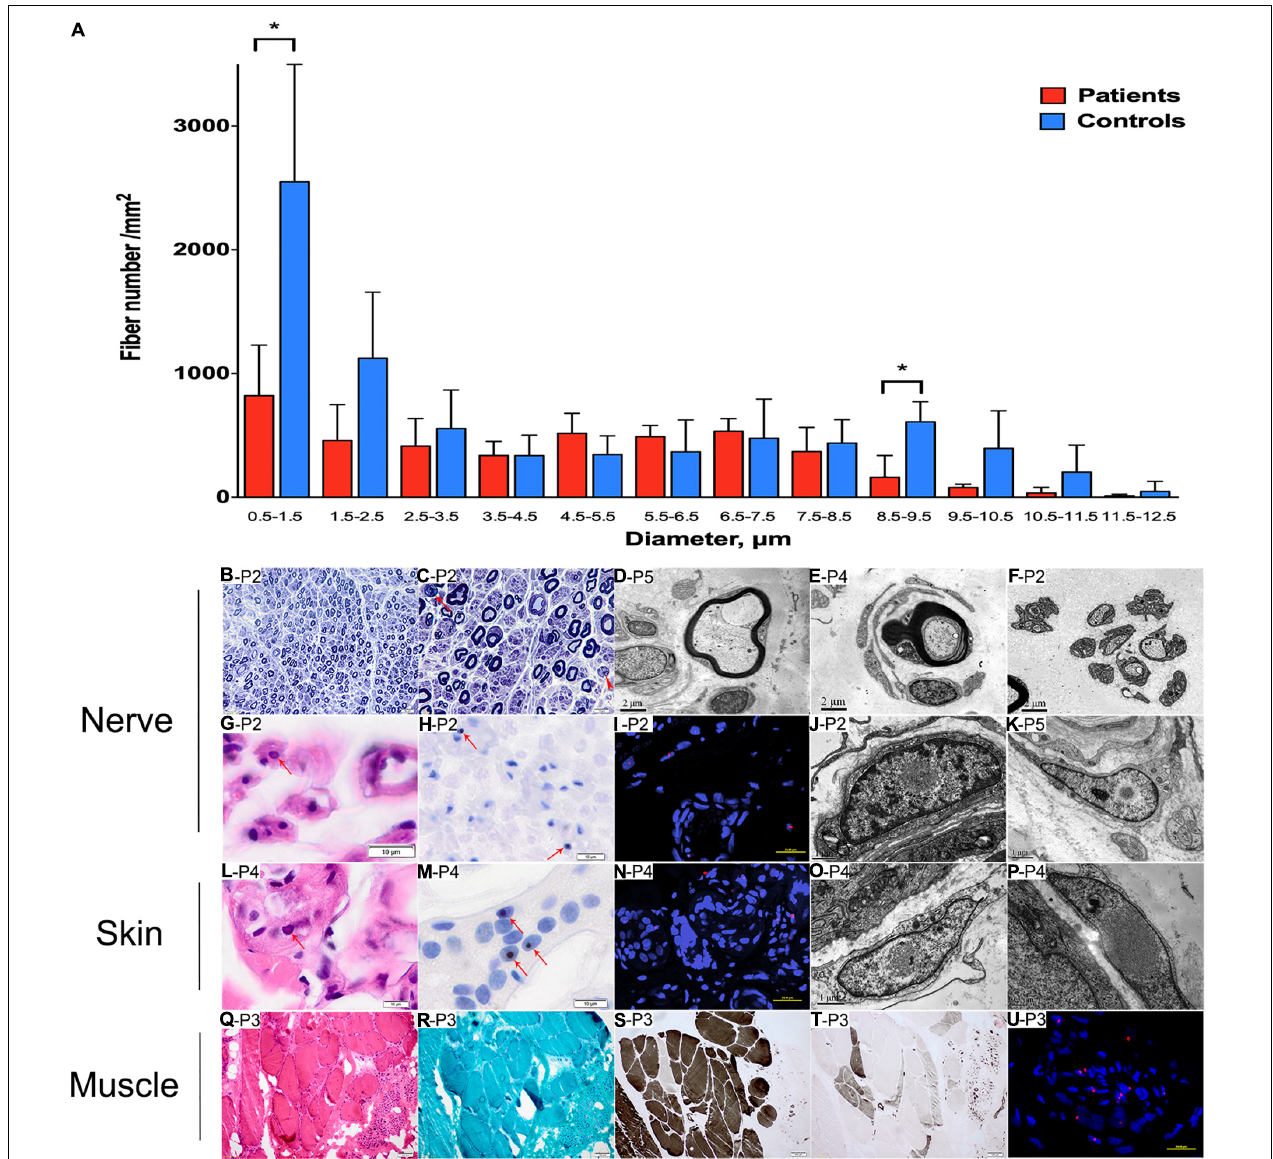
FIGURE 4 | Pathological changes of peripheral nerve, skin, and muscle. (A) Distribution pattern of myelinated fibers in patients compared with the control. Data are presented as mean ± SD. Statistical analysis was performed by Student’s t-test. ∗ p < 0.05. ( B–K , nerve samples; L–P , skin samples; Q–U, muscle samples) A reduced density of myelinated fibers with thinly myelinated fibers (B) , rare axonal degeneration ( C , arrow) and regeneration clusters ( C , arrowhead). Thinly myelinated fibers (D) , atypical onion-bulb (E) , and denervated Schwann cell units (F) in EM. Eosinophilic (G) and p62-positive (H,I) intranuclear inclusions in sural nerve. On EM, intranuclear inclusions containing filamentous aggregates were observed in fibroblast (J) and perivascular cells (K) in sural nerves. Eosinophilic (L) and p62-positive (M,N) intranuclear inclusions in skin. On EM, intranuclear inclusions containing filamentous aggregates were observed in fibroblast (O,P) . Neurogenic changes (Q,S,T) in muscle pathology without rimmed vacuoles (R) , and p62-positive (U) intranuclear inclusions in muscle. (B,C) , toluidine blue staining; (G,L,Q) , H&E staining; (H,M) , anti-p62 staining; (S) , ATP staining (pH 4.4); (T) , ATP staining (pH 10.7); (I,N,U) , nuclei were counterstained with DAPI. Scale bars: (B) , 20 µ m; (C) , 10 µ m; (D–F) , 2 µ m; (G,H,L,M) , 10 µ m; (I,N,U) , 25 µ m; (J,K,O) , 1 µ m; (P) , 0.5 µ m; (Q–T) , 100 µ m. P2, patient 2; P3, patient 3; P4, patient 4; P5, patient